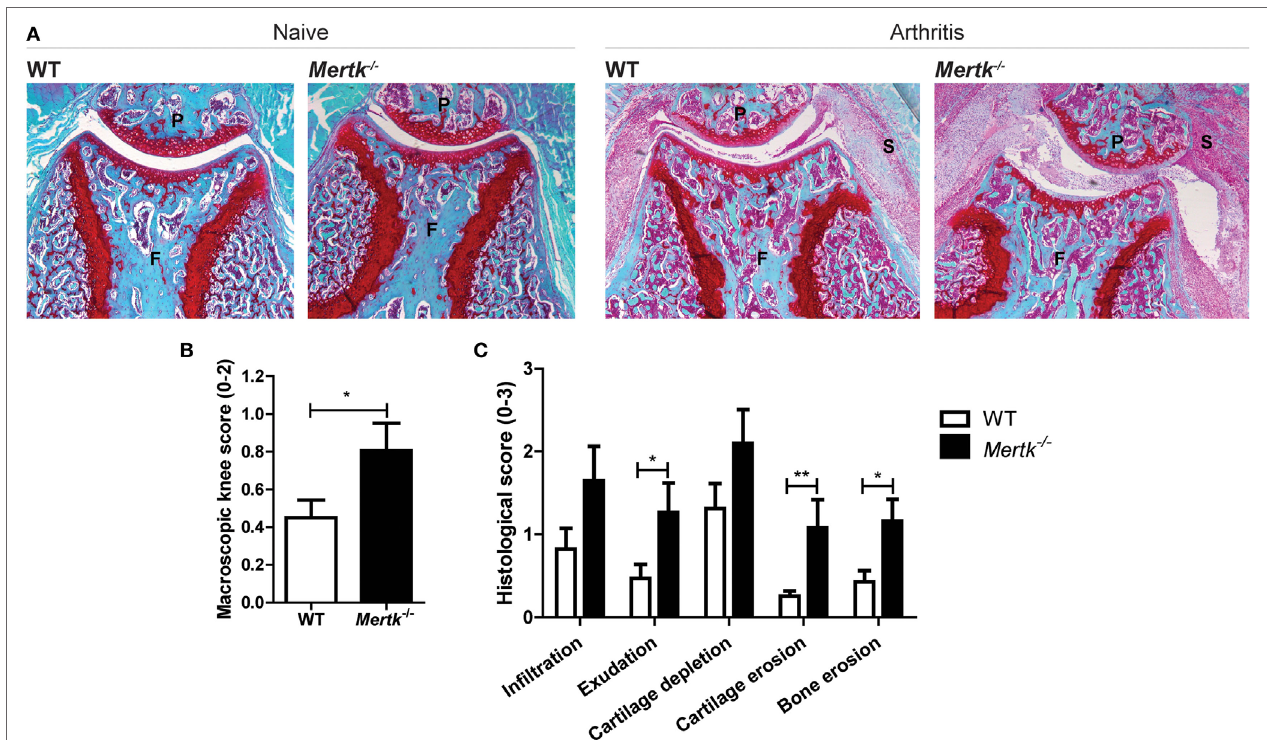
FigUre 1 | Effect of genetic ablation of Mertk on naive and arthritic knee joints with KRN serum transfer arthritis (STA). (a) Naive ( n = 6 mice) or arthritic (KRN STA) wild-type (WT) and Mertk − / − mice ( n = 9–15 mice) were euthanized at day 7. Shown are representative pictures of histological knee joint sections stained with safranin O and fast green. (b) Macroscopic score of knee joints of arthritic mice as determined by swelling and blood vessel formation ( n = 18–30 knee joints). (c) Histological knee joint sections of arthritic mice were scored for the arthritis parameters depicted. Three semi-serial sections per joint were scored in a random and blinded manner with an arbitrary score from 0 to 3 ( n = 10–18 knee joints). P, patella; F, femur; S, synovium. For (b,c) , data are represented as mean + SEM. * p < 0.05, ** p < 0.01 with unpaired t